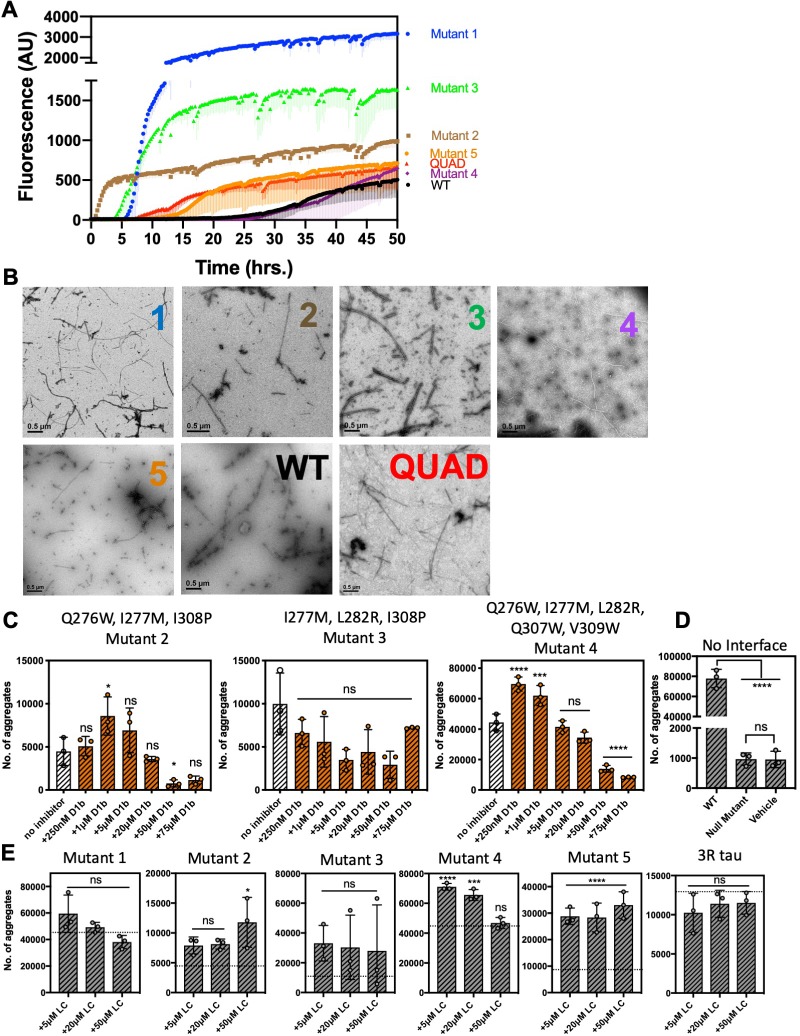
Extended tau40 interface mutation data.(A, B) Tau 40 interface mutant constructs form fibrils. (A) 10 μM of each tau40 constructs was incubated with 0.5 mg/ml heparin under shaking conditions at 700 RPM at 37°C. Fibril formation was monitored using ThT fluorescence. Lines show the average of three technical replicates. (B) Negative-stain TEM analysis confirms the results of the ThT assays in (A). Scale bars are 0.5 µm. (C, D, E) Extended data of seeding by tau interface mutation fibrils in tau-K18CY biosensor cells. The cells were seeded with 250 nM tau40 fiber (final concentration); in samples with inhibitor, tau40 fibers were incubated with indicated final concentrations of peptide inhibitor for one hour prior to addition to cells. Average number of aggregates at the indicated inhibitor concentrations, Bars represent mean with individual technical replicates, error bars display one standard deviation (n = 3; ns = not significant; *, p<0.05; ***, p<0.0005; ****, p<0.0001 0001 using an ordinary one-way ANOVA- Dunnett’s in (C, E) relative to leftmost column (C) or dotted line (E). Panel D was calculated using ANOVA-Tukey’s, relative to leftmost column and between Null mutant and vehicle columns). (C) Interface mutations less affected by D1b. (D) Construct containing all interface mutations is seeding incompetent. (E) Seeding interface mutants are not reduced by control inhibitor LC. Extended ANOVA data included as a supplementary file.